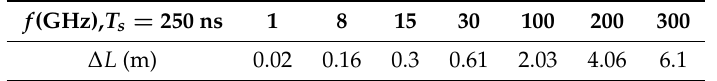
Table 1. Fabry–Perot and Michelson interferometers OPD ∆ L for target frequency f .